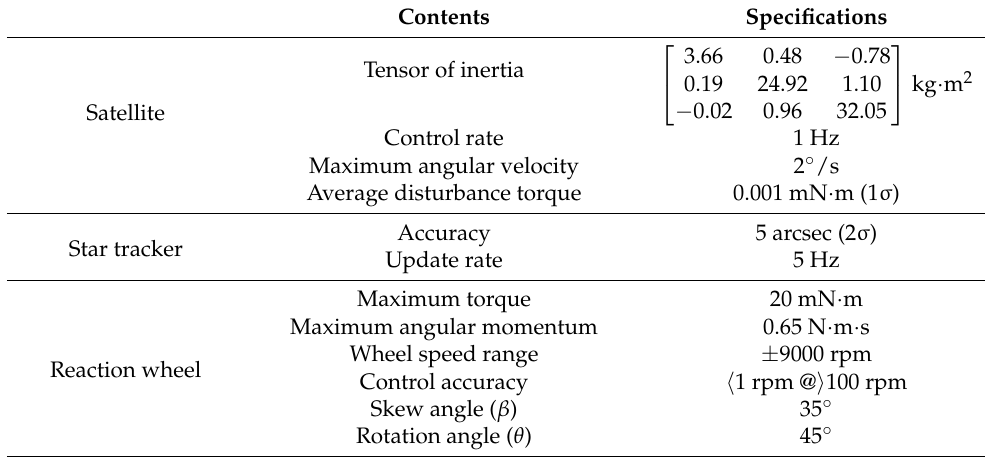
Table 6. Simulation conditions of attitude control for multistatic SAR